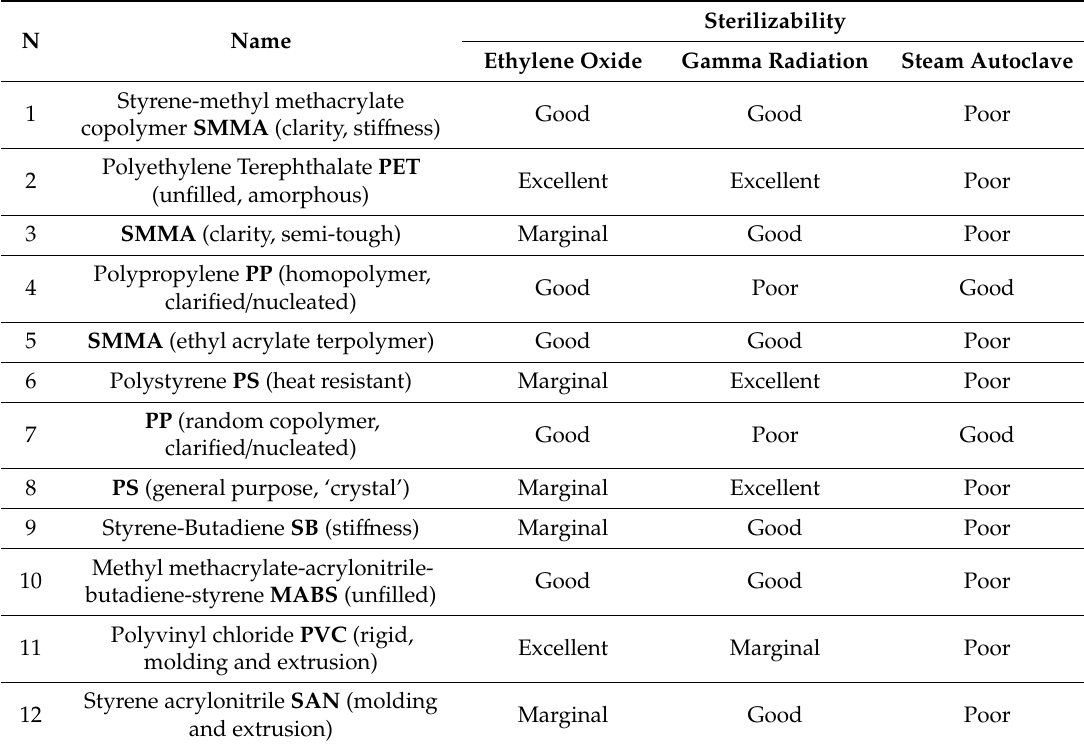
Table 3. Sterilizability of candidate materials is given in comparison with the exposure to ethylene oxide (EtO) gas and rated as excellent, good, marginal and poor. Candidates 1, 2, 6 and 12 scored highest ranks in the Section 3. Materials Selection (Data from CES EduPack 2019, Granta Design Limited, Cambridge, UK, 2019